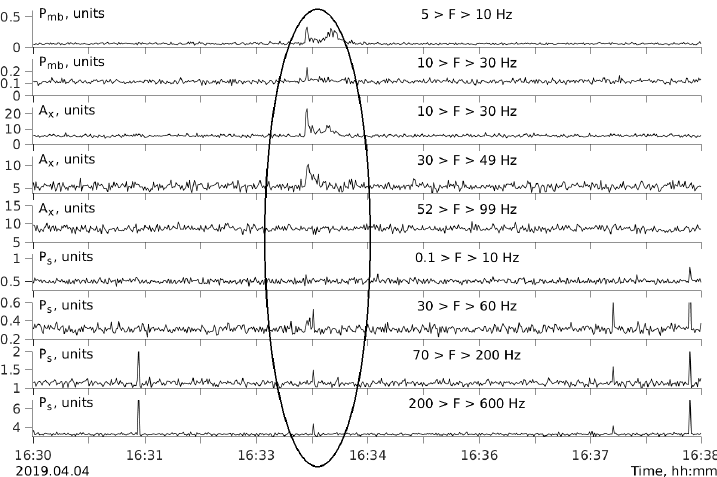
Figure 6: Atmospheric acoustic signal variations P mb recorded by the microbarometer, geoa- coustic signal A x recorded by the geophone (X component), geoacoustic signal P s recorded by the hydrophone № 1 of high-frequency geoacoustic system from 16:30 to 16:38 UT on April 4, 2019. Ellipse shows the simultaneous amplitude jump